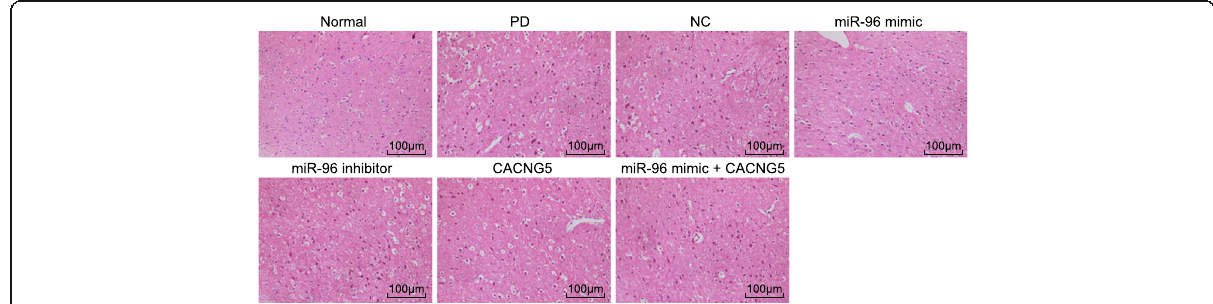
Fig. 3 HE staining shows that miR-96 inhibitor increases the number of substantia nigra (× 100). n = 10 in each group; HE, hematoxylin-eosin;